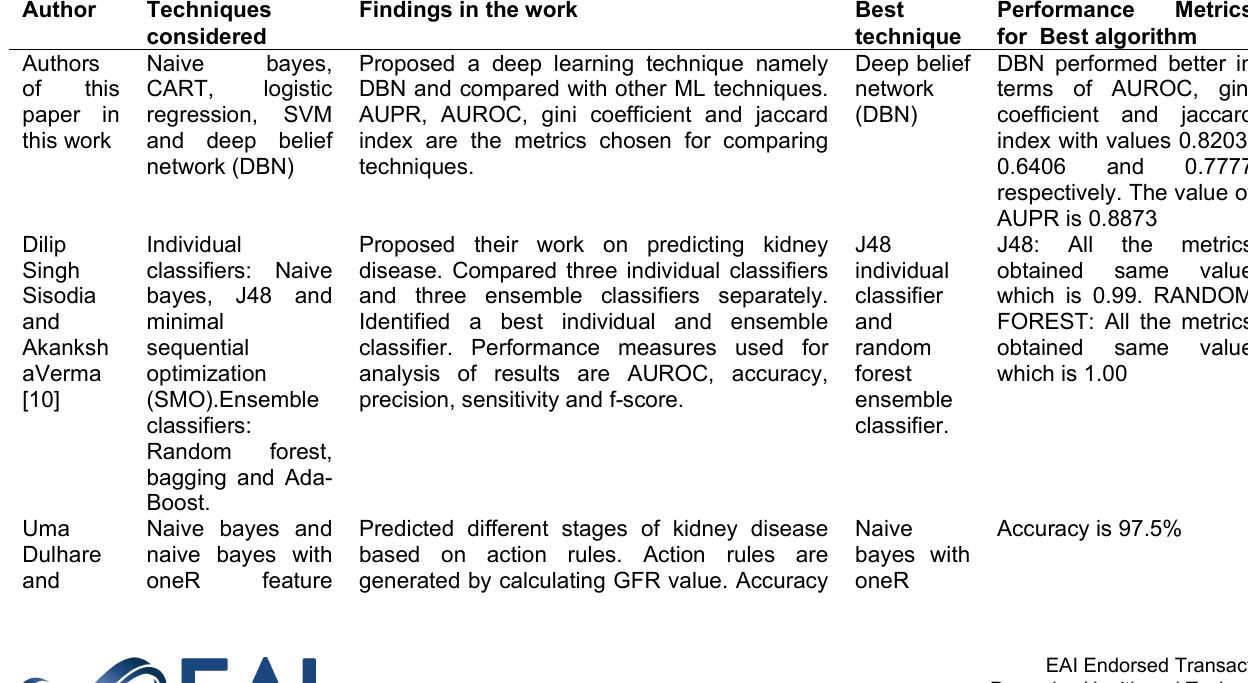
Table 9. Analysis of proposed work and classifiers from literature